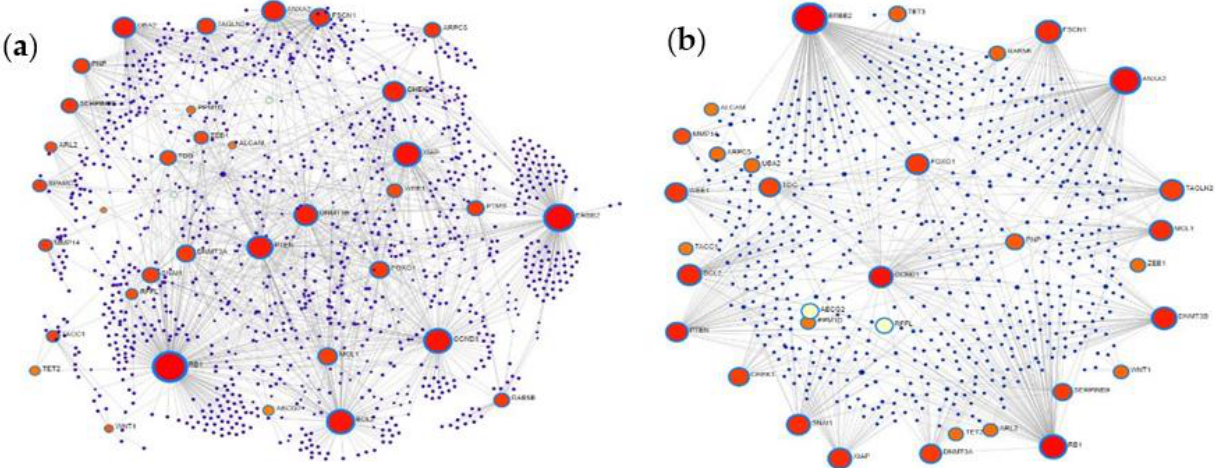
Figure 7. Topology of the general and cortex-specific protein – protein interaction (PPI) minimum networks constructed from common targets of DE miRNAs using the NetworkAnalyst tool. Part ( a , b ): The general and cortex-specific minimum PPI networks, respectively. Nodes represent proteins, only the major hub nodes are labeled in the networks. The size of the nodes corresponds to their degree